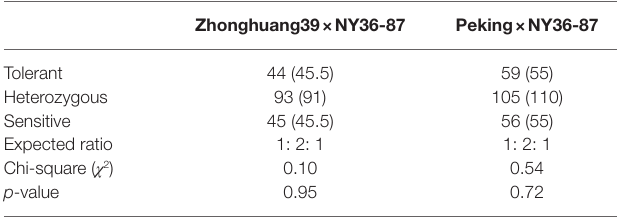
TABLE 1 | Segregation ratio in F 2 populations for salt tolerance based on phenotypic evaluation of F 3 of the crosses made between wild soybean (NY36- 87) and two salt-sensitive cultivars (Zhonghuang39 and